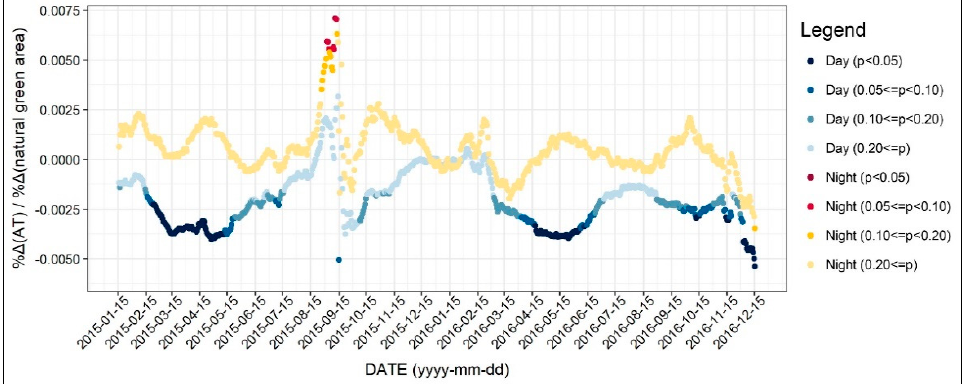
Figure 16. Changing patterns in the regression coefficients and their significances (natural green area). Int. J. Environ. Res. Public Health 2019 , 16 , x FOR PEER REVIEW